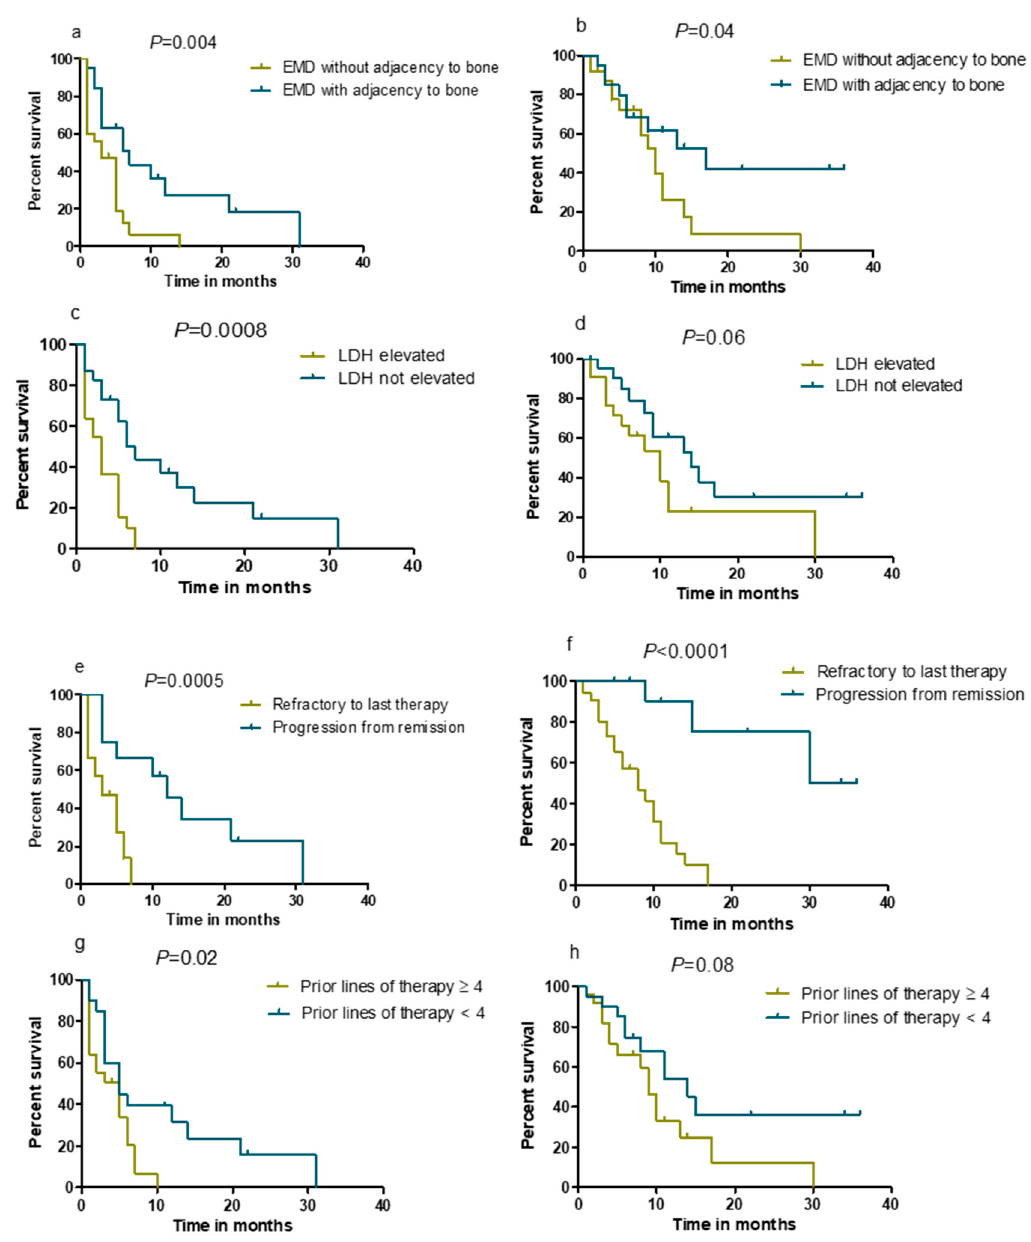
Figure 2. Progression-free survival (PFS) ( a ) and overall survival (OS) ( b ) in patients with extramedullary disease (EMD) adjacent to bone or not (EMD with adjacency to bone, n = 20; EMD without adjacency to bone, n = 25). PFS ( c ) and OS ( d ) in patients with normal vs. elevated lactate dehydrogenase (LDH) level (LDH < 250 IU/l, n = 23; LDH ≥ 250 IU/l, n = 22). PFS ( e ) and OS ( f ) in patients who were refractory to the last therapy line ( n = 33) vs. who were not ( n = 12). PFS ( g ) and OS ( h ) of patients with ≥ 4 prior therapy lines ( n = 25) and < 4 prior therapy lines ( n = 20).